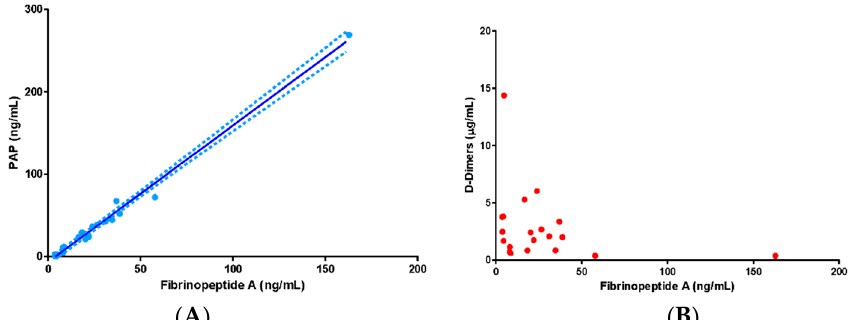
Figure 1. Association between plasma levels of fibrinopeptide A and plasmin–antiplasmin (PAP) complexes ( panel A ) and D-dimers ( panel B ). Data in the text.